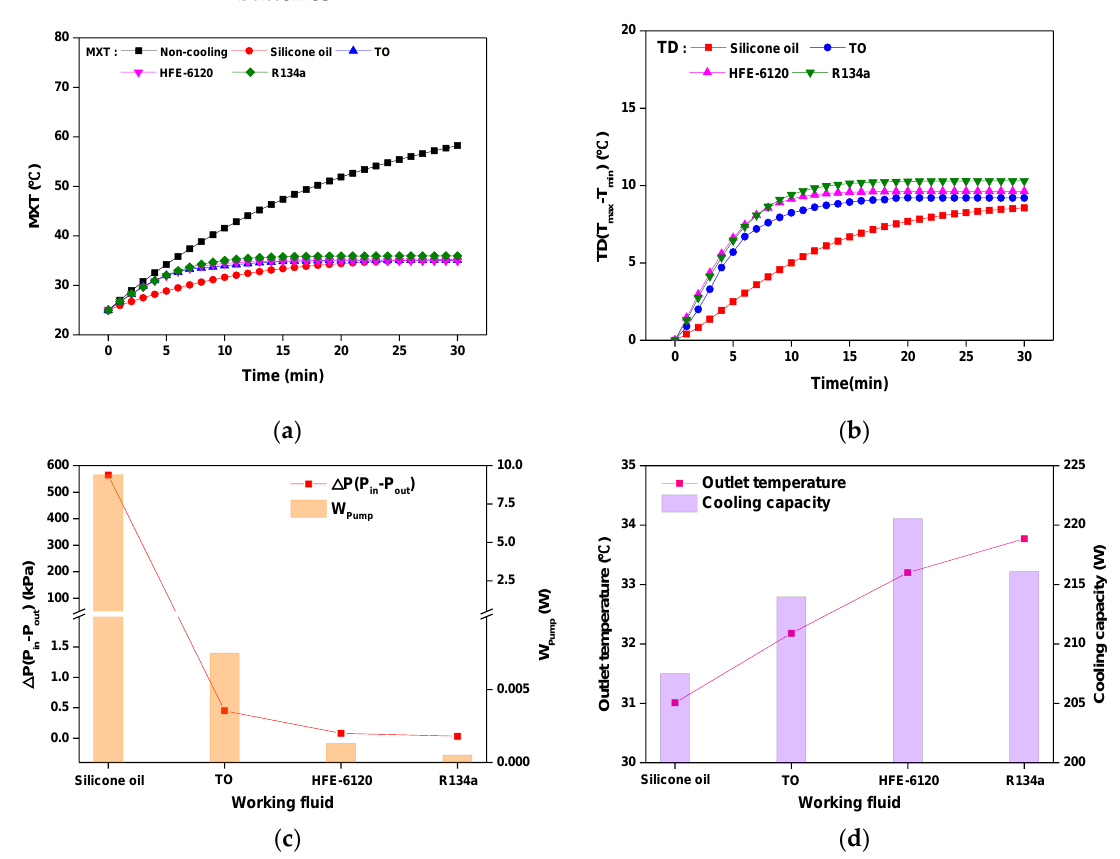
Figure 6. Variation of cooling performance according to working fluids: ( a ) MXT of battery according to time; ( b ) TD of battery according to time; ( c ) Pressure drop and pump power for different working fluids; ( d ) Outlet temperature and cooling capacity for different working fluids.